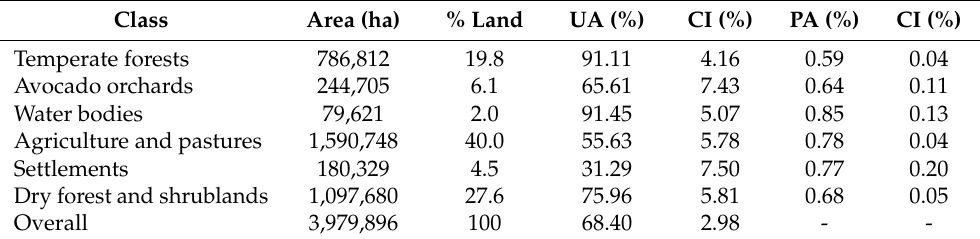
Table 1. Classes of the land-use and land-cover map for the Avocado Belt in the state of Michoac á n, Mexico. The extension and percentage of the landscape that represents each of the classes are presented. User (UA) and producer accuracy (PA), with the corresponded confidence intervals (CI) are shown. Overall accuracy of the classification is